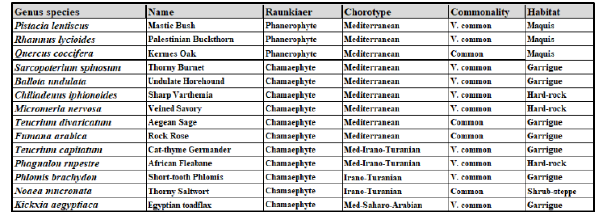
Table 1. Results of UAV mapping study in the Gad Hills Nature Reserve. Phanerophytes / chamaephytes reflect presence in the winter 2022/23 based on 5 plant leaf-on minimum.